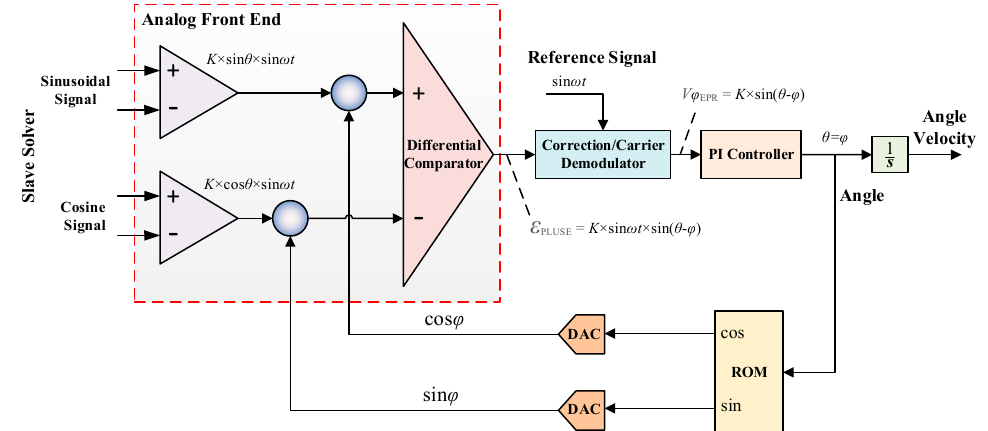
Figure 5. Basic principle of RVDT solution unit.